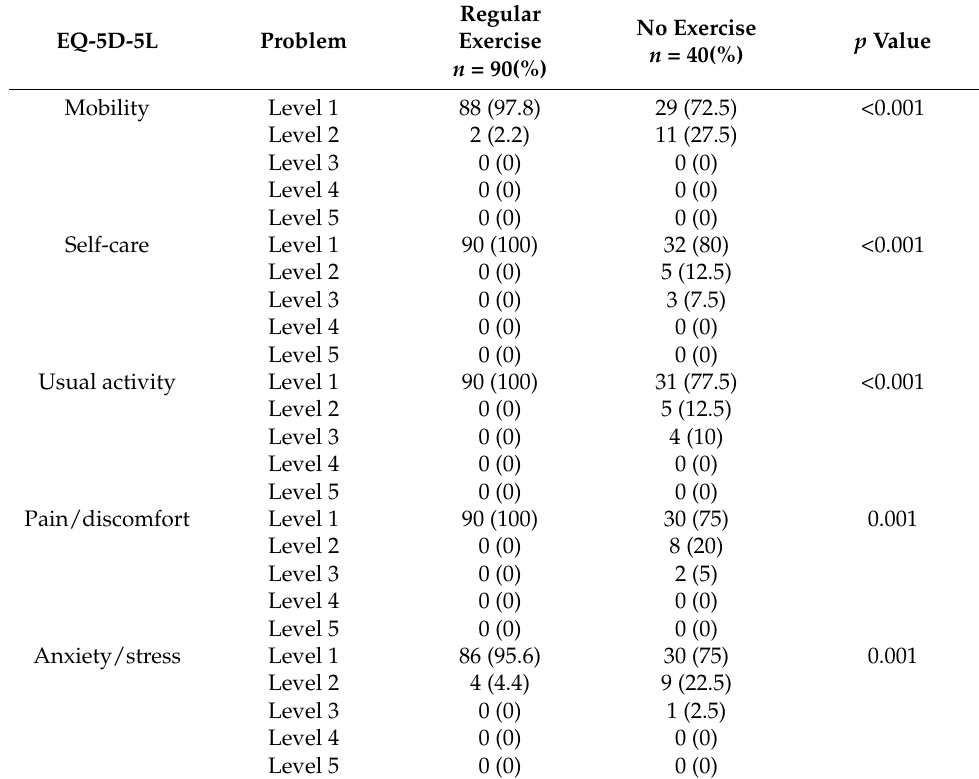
Table 12. Health-related quality of life EQ-5D-5L generic questionnaires related to regularly exercise vs. no sport before and after surgery.